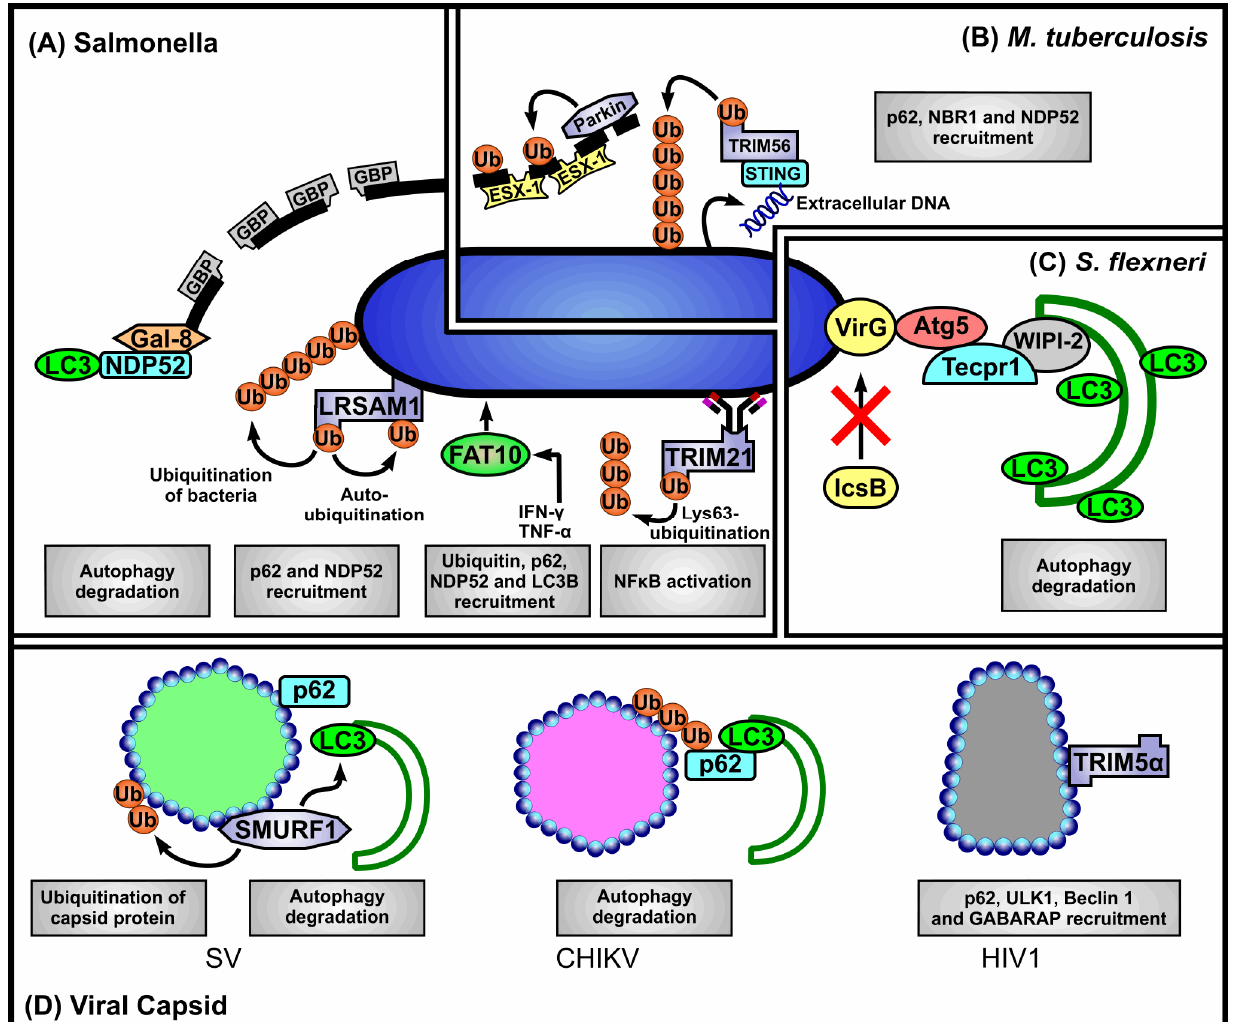
FIGURE 1: Scenarios for SLR-dependent autophagy induction. (A) Salmonella . Autophagic clearance of Salmonella that have ‘escaped’ from phagosomes, or reside in permeabilised phagosomes may be mediated via several scenarios. First, Salmonella -containing phagosome mem- brane segments that occur as a consequence of loss of membrane integrity, in part mediated by guanylate-binding proteins (GBPs), are tar- geted by direct binding of galectin 8 (Gal-8) and subsequent binding of NDP52 leading to their recognition as autophagosome cargo. Second, the E3 ligase LRSAM1 can recognise as yet unidentified conserved regions of bacterial surface components. Bacterial proteins are ubiqui- tinated by LRSAM1, but their identity also remains to be established. Auto-ubiquitination of LRSAM1 at internal lysine residues is implicated in p62 recruitment. Additionally NDP52 is recruited to bacteria. Third, simultaneous decoration of bacteria with FAT10, ubiquitin, p62, NDP52 and LC3B may occur, but it is unclear whether FAT10 binds directly to bacterial structures, or to cellular structures proximal to, or surrounding them. Fourth, antibody-bound bacteria may interact with TRIM21 whose RING domain catalyses formation of free K63 ubiquitin chains required for downstream NFκB-stimulated inflammatory response and LC3 recruitment. (B) M. tuberculosis . The E3 ligase Parkin ca- talyses Lys63-linked polyubiquitination of bacteria-containing phagosome membrane segments which have been permeabilised by the se- creted mycobacterial effector system ESX-1 (early secretory antigenic target 6 system 1). Subsequently p62, NBR1 and NDP52 are recruited for delivery of the ‘marked’ membranes to autophagosomes. Additionally, bacteria ‘exposed’ to the cytosol can elicit the host cytosolic DNA sensing pathway through bacteria-intrinsic surface-located extracellular DNA that is recognised by stimulator of interferon gene 1 (STING). STING is targeted by TRIM56 which catalyses Lys-63 ubiquitination of STING-targeted bacteria subsequently leading to the recruitment of p62, NDP52 and TBK1 to mediate autophagy. (C) S. flexneri . Atg5 binds the bacterial surface protein IcsA of bacteria lacking IcsB (IcsB-) thereby targeting them for autophagy. Tectonin domain-containing protein (Tecpr1) bridges between the Atg5-targeted bacteria and the WIPI2-positive phagophore membrane. (D) Viral capsids. Direct interaction of p62 and of the SMAD specific E3 ubiquitin ligase 1 (SMURF-1) with Sindbis virus (SV) capsid protein is required for the subsequent recruitment of LC3. Chikungunya virus (CHIKV) capsid is ubiquitinated, bound by p62 and targeted to autophagy, however capsid ubiquitination appears to be independent of SMURF-1. The human immunodefi- ciency virus (HIV) p24 capsid is directly recognised by TRIM5α (without a need for ubiquitination) and delivered it to autophagosomes. TRIM5α binding to capsid also mediates interactions with several autophagy-associated components, including p62, ULK1, Beclin 1 and